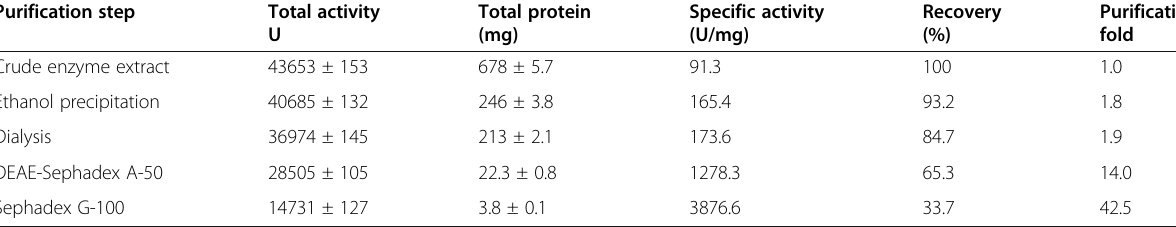
Table 3 Summary of purification profile of Aspergillus sp. DHE7 β -glucosidase